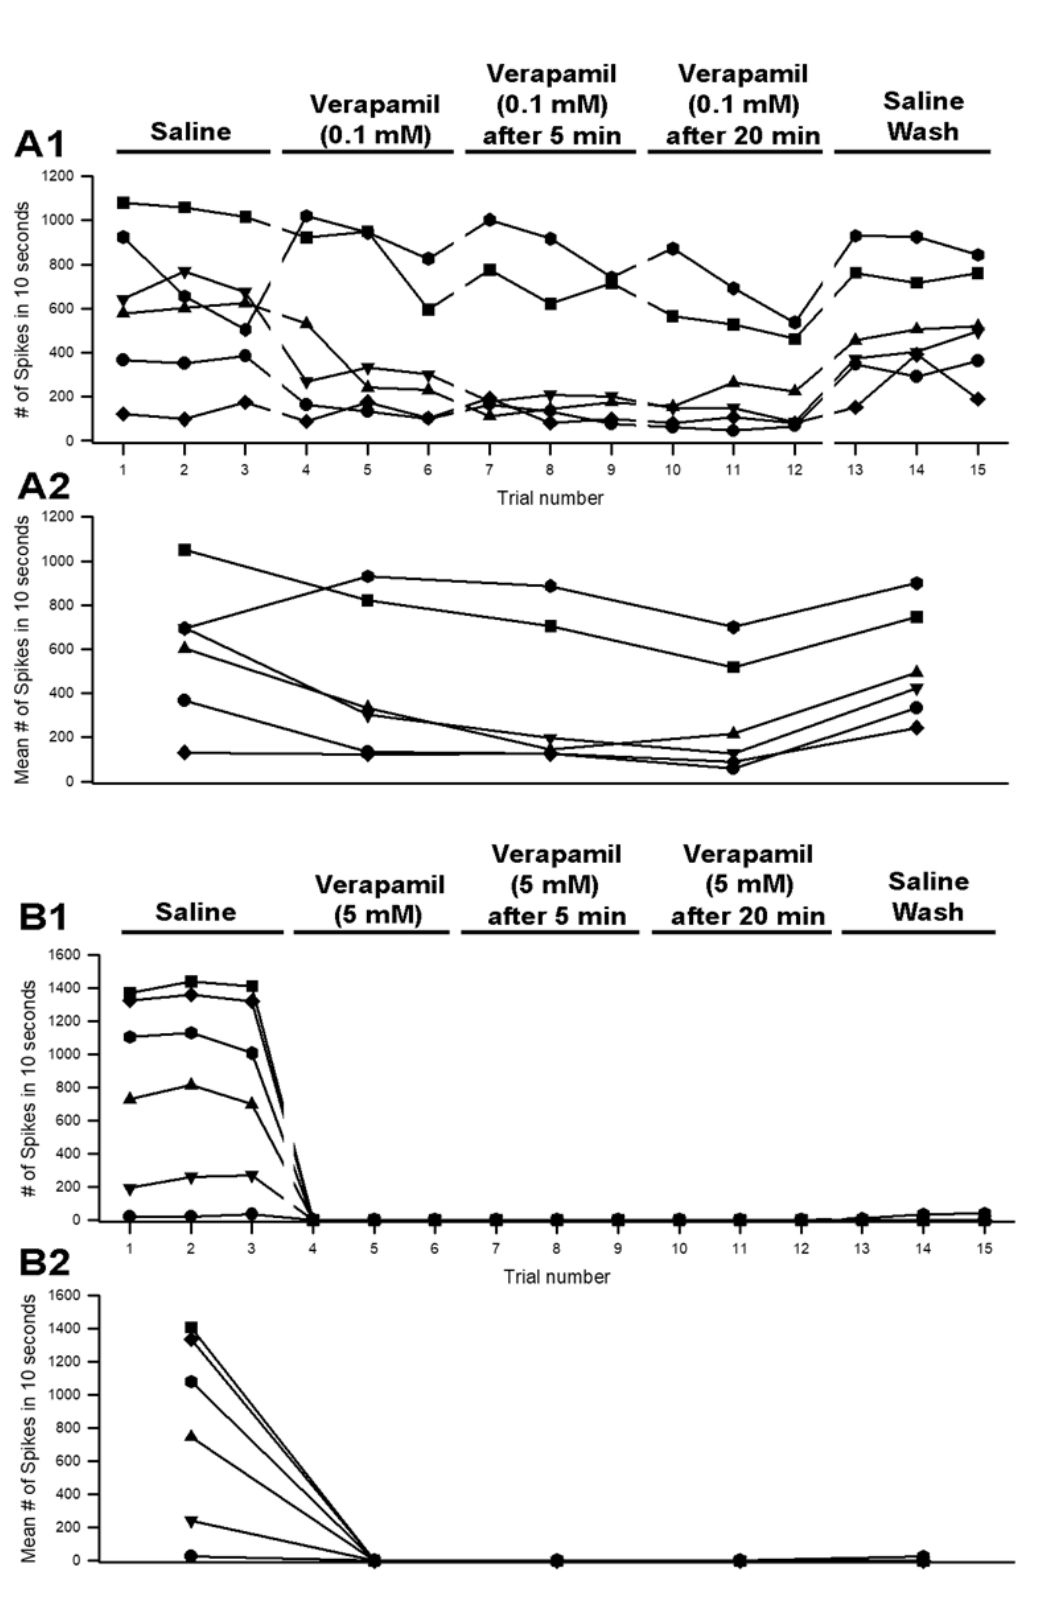
Figure 9. The acute effect of verapamil (0.1 mM and 5 mM) on neural activity of the PD organ. ( A1 ) The number of spikes measured in the 10 s window from the beginning movement of the joint starting from a bent position (90 degrees) to fully extended within 1 s and held in an extended position for the next 9 s. This paradigm is repeated three times for each condition. Each line represents a different preparation of a PD organ. Three trials were undertaken with saline, three trials were done immediately after switching the bath to verapamil (0.1 mM), and they were examined again after incubation for 5 and 20 min. The last step was to rinse the preparation with fresh saline twice and then move the joint three more times. Each movement was separated by at